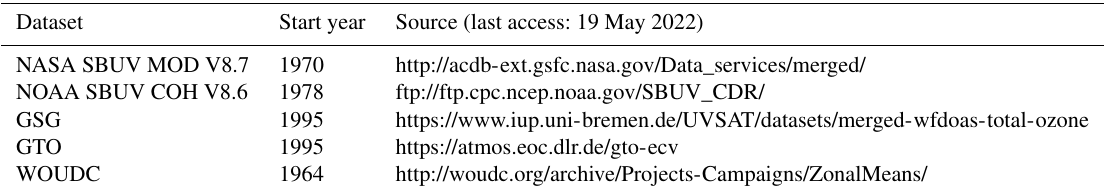
Table 1. Source of merged total ozone datasets.